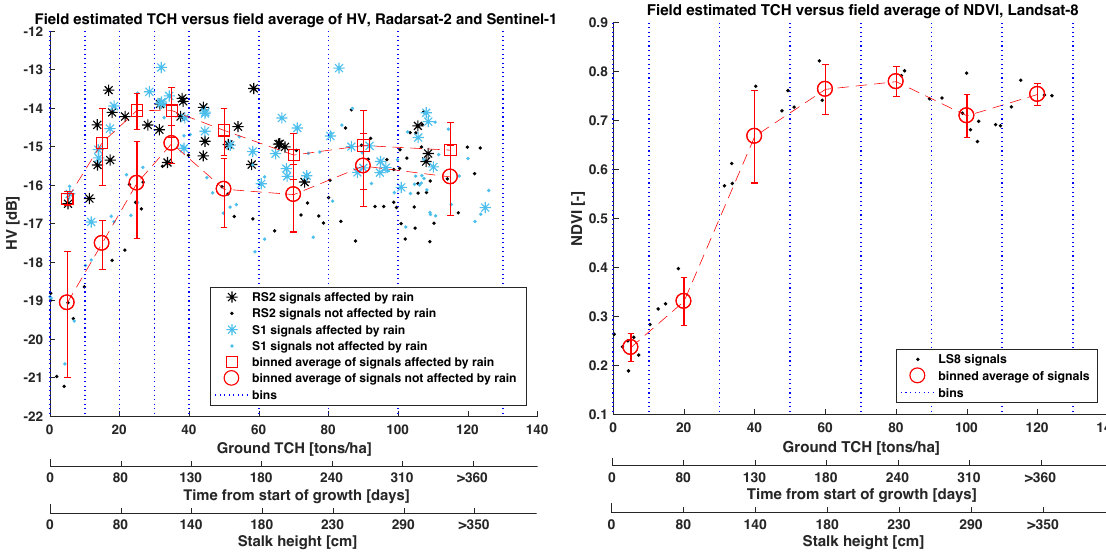
Field estimated TCH versus field average of HV, Radarsat-2 and Sentinel-1